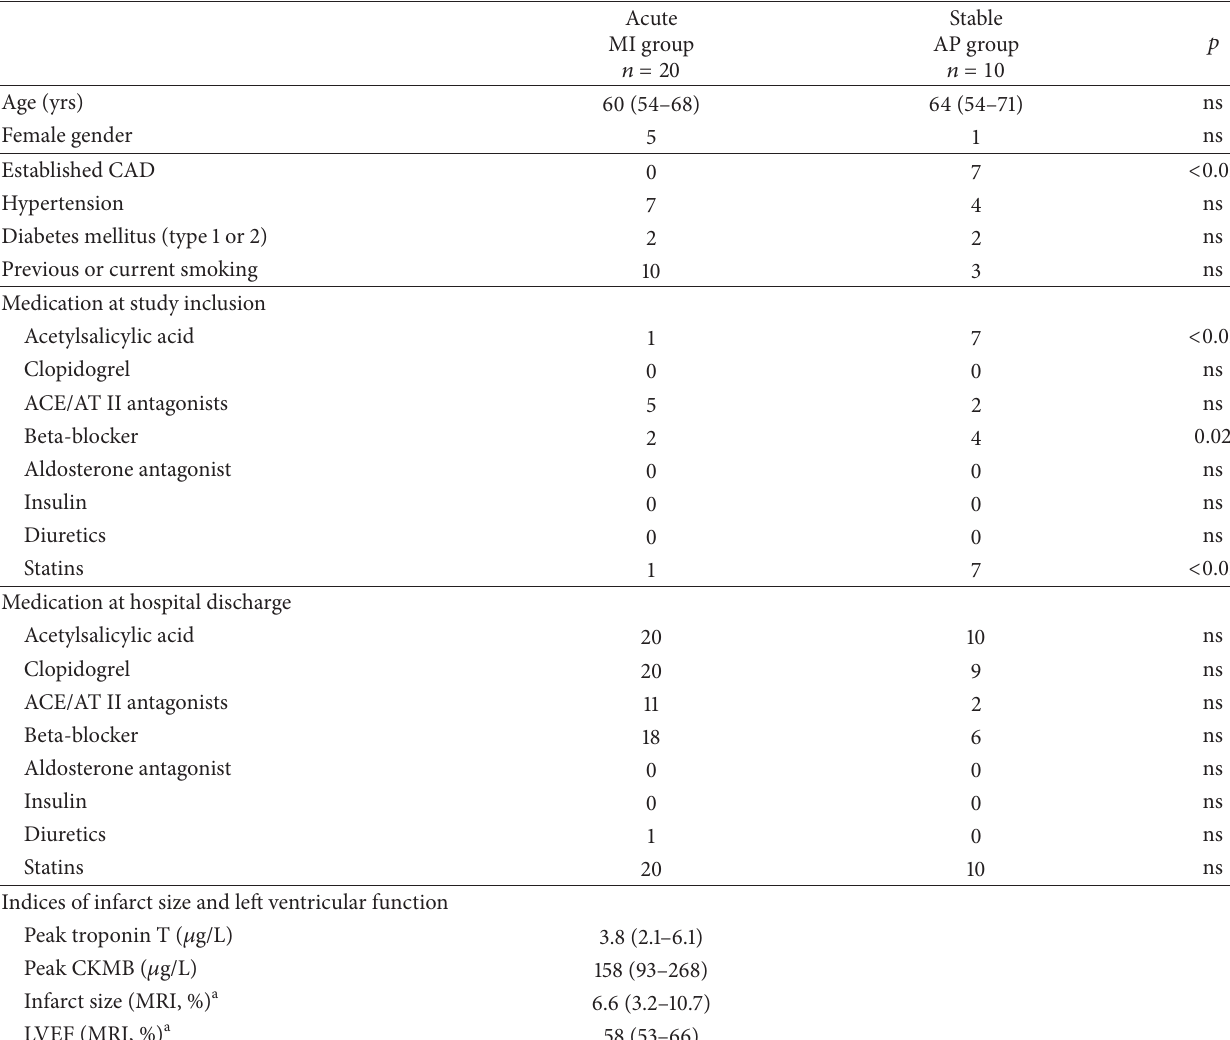
Table 1: Clinical characteristics of the study population.